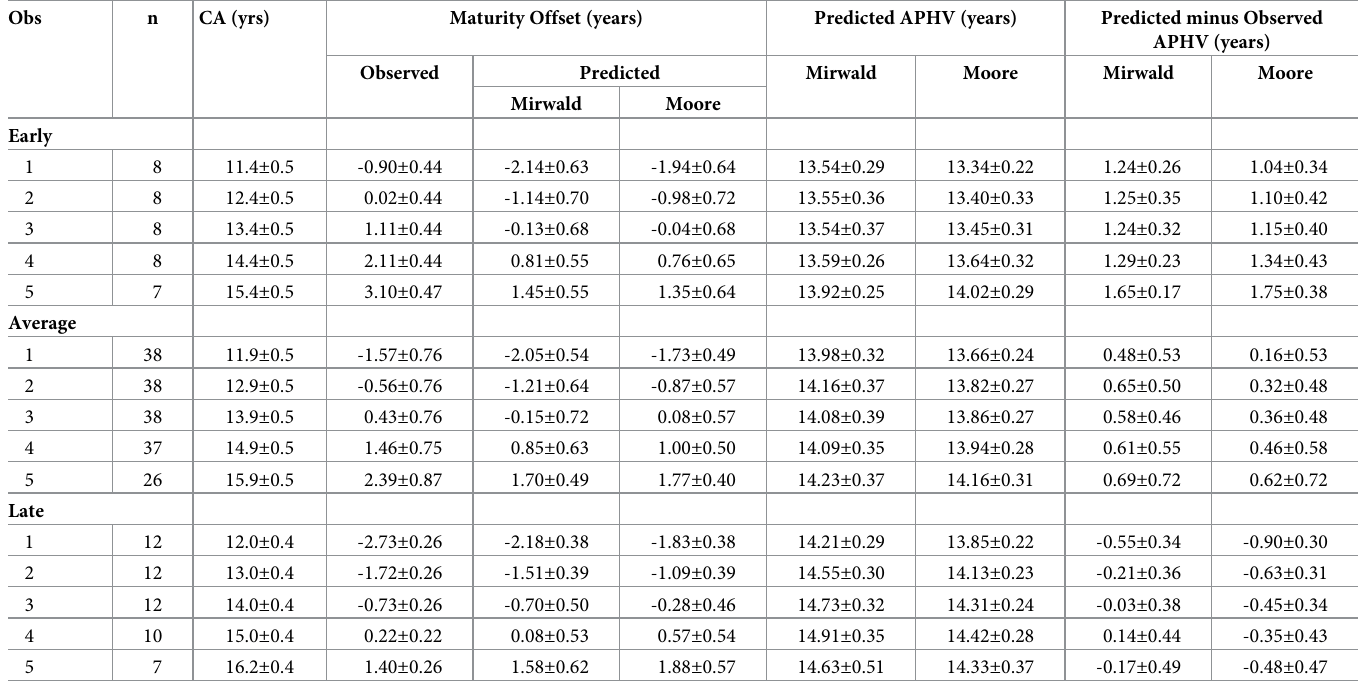
Table 3. Sample sizes and descriptive statistics (mean ± standard deviation) for chronological age (CA) at prediction, observed maturity offset and predicted matu- rity offset, predicted ages at PHV and the difference of predicted age at PHV minus observed ages at PHV (criterion) with the original (Mirwald) and modified (Moore) equations at each observation in players classified as advanced, average and delayed based on observed ages at PHV †